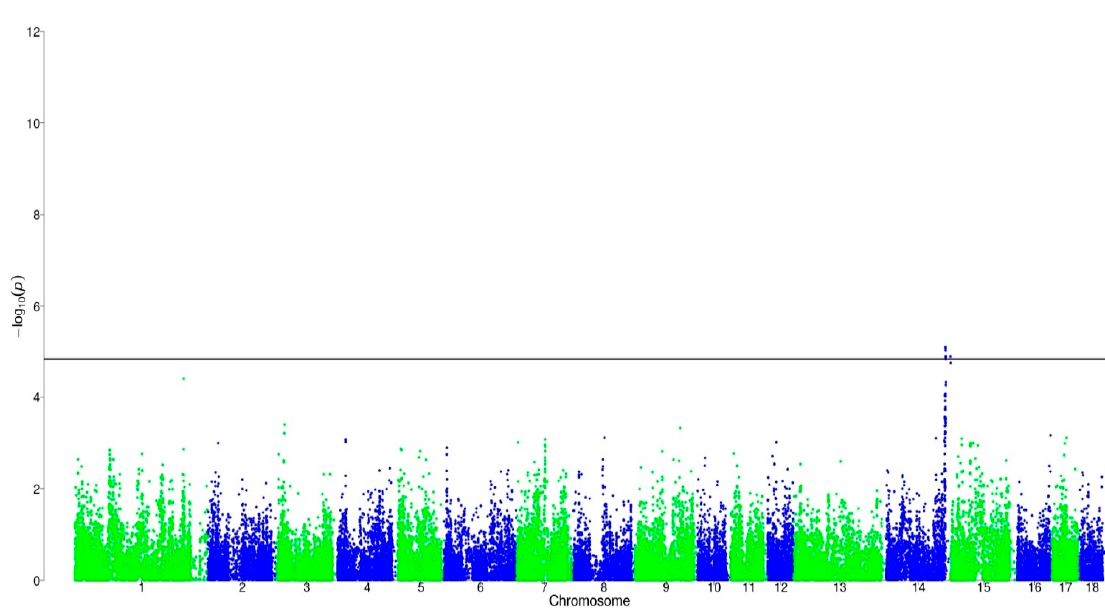
Figure 3. Distribution of SNPs for log-transformed skatole in BT LR H. The black line corresponds to the threshold of chromosome-wide significance.